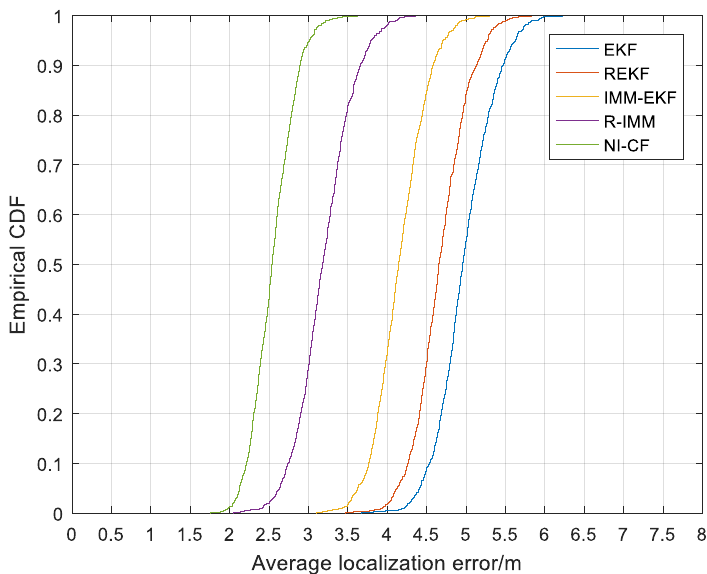
Figure 7. The cumulative distribution function (CDF) versus the average localization error (ALE). Table 4. The default parameters for uniform distribution.